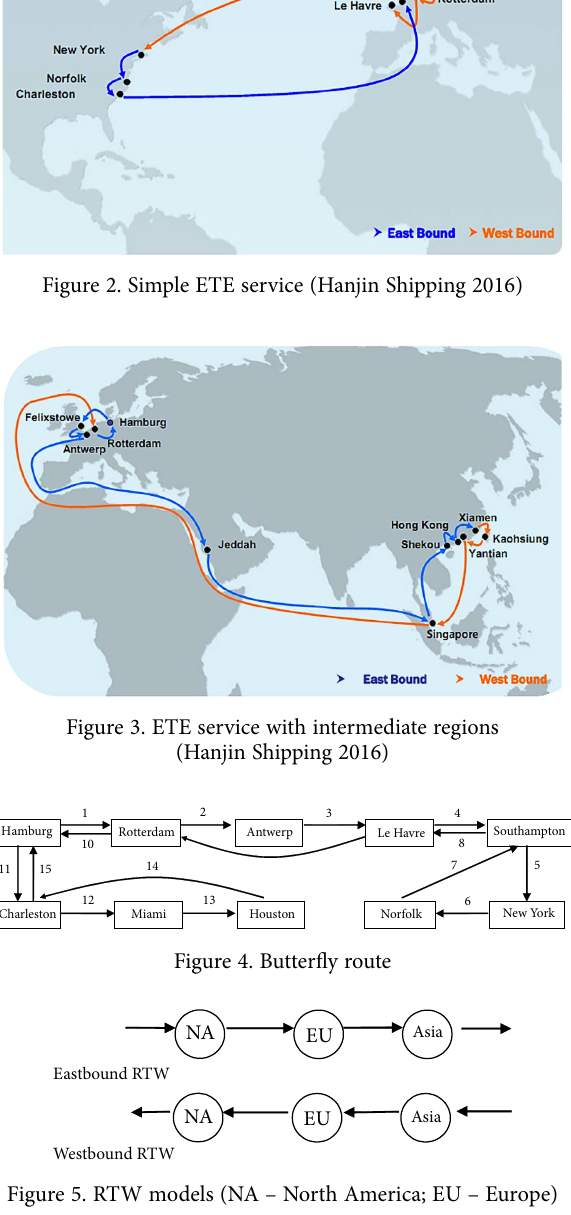
Figure 5. RTW models (NA – North America; EU –